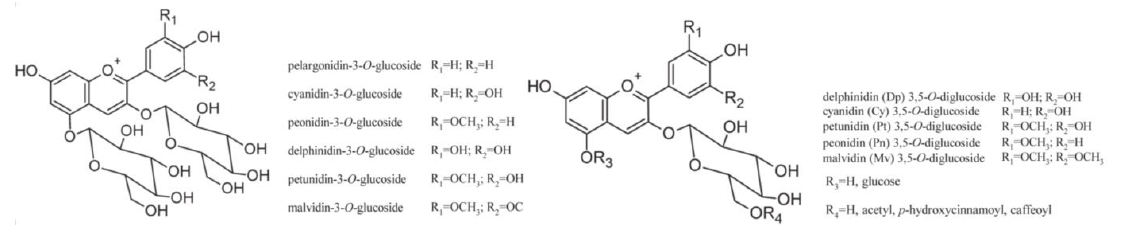
Figure 4. Structures of anthocyanins present in grapes [11].